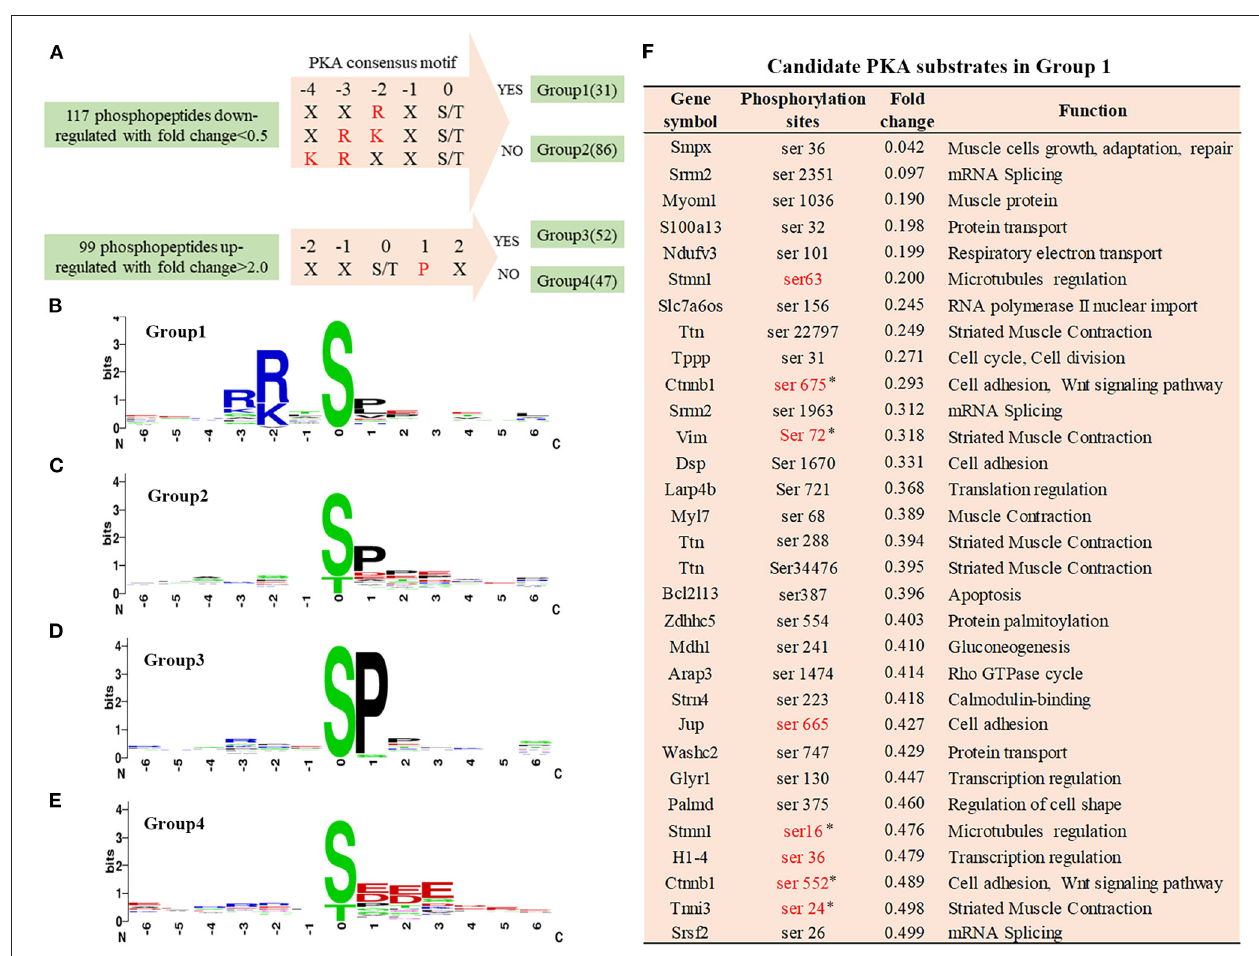
FIGURE 3 | Phosphorylation-specific motif analysis and candidate PKA substrates. (A) Grouping of differentially phosphopeptides. The 117 hypophosphorylated peptides in Cypher-KO mice were categorised into two groups: Group 1, containing phosphopeptides with PKA consensus motifs and Group 2, without the motifs. The 99 hyperphosphorylated peptides were divided into the other two groups: Group 3, containing phosphopeptides with SP motif and Group 4, without the motif. (B–E) The logo motif of phosphosites in Group 1 (B) , Group 2 (C) , Group 3 (D) , and Group 4 (E) . Sequence logos were created using WebLogo. (F) The list of candidate PKA substrates regulated by Cypher in Group 1. Sites marked in red are the reported PKA phosphorylation sites. Sites selected for further study are marked with an asterisk